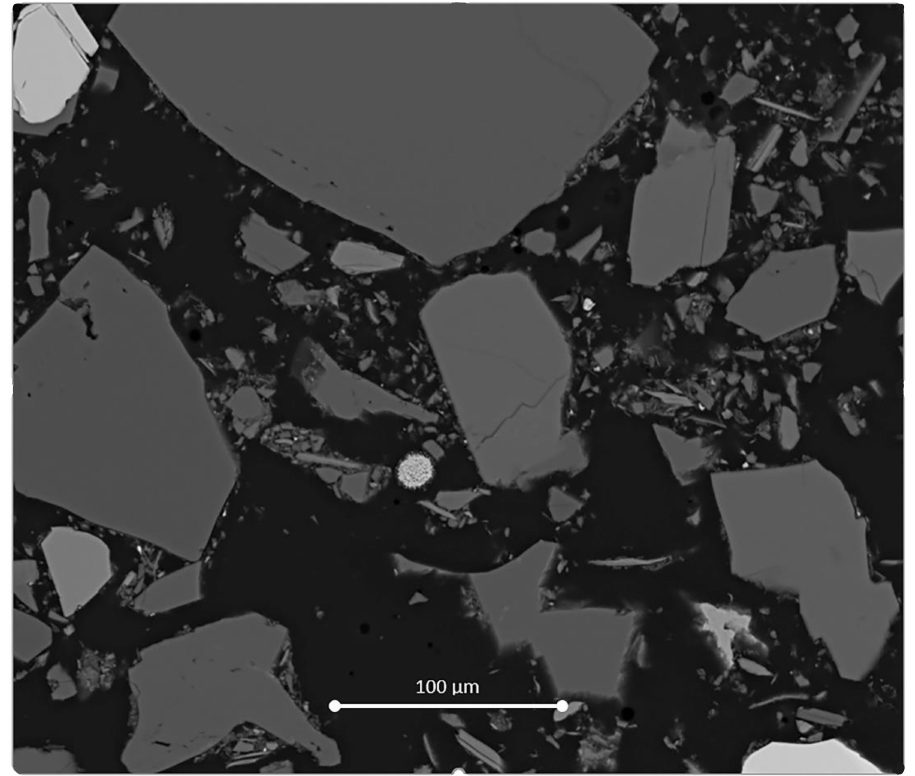
Figure 14. BSE images of pyrite framboid (white centre) in sample GTT-11-13-35.3 m. Table 5. MLA-defined mineral data (area %) in sonic drill hole samples, Voisey’s Bay. SS-11